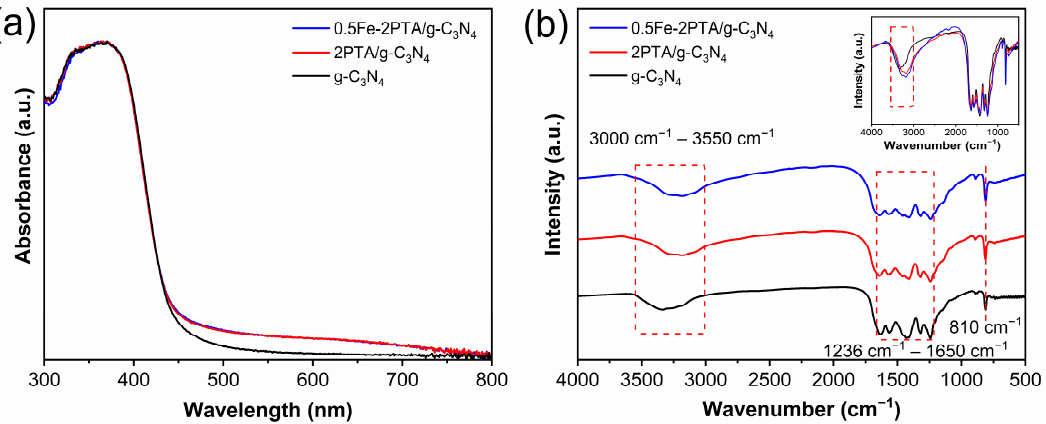
Figure 2. ( a ) UV–Vis diffuse reflection spectra and ( b ) FT-IR patterns of g-C 3 N 4 , 2PTA/g-C 3 N 4 and 0.5Fe-2PTA/g-C 3 N 4 (inset shows comparison of three FT-IR curves). To investigate the interface interactions between PTA and g-C 3 N 4 in PTA/g-C 3 N 4 , Fourier-transform infrared (FTIR, Bruker, Karlsruhe, Germany) spectra of the samples were analyzed, as shown in Figures 2b and S3. As shown in Figure S3a, PTA shows the carboxylic O-H and C=O stretching peaks at 3400 and 1610 cm − 1 , C-H stretching peaks at 3098, 2965 and 2915 cm − 1 , thiophene ring vibration peaks at 1533, 1437 and 1356 cm − 1 and the C-S stretching vibration peak of the thiophene ring at 902 cm − 1 [41–44]. It is worth noting that PTA presents a substantial absorption peak at 788 cm − 1 , corresponding to C β -H out-of-plane vibration, indicating that the α - α coupling is the dominant form of C-C bonding for the as-prepared PTA and there is almost no α - β coupling form [45]. As illus- trated in Figure 2b, g-C 3 N 4 shows a broad peak at around 3000–3550 cm − 1 , originating from the terminal -NH 2 . The peak at around 810 cm − 1 is assigned to the hepazine ring bending vibration, and the set of peaks from 1236 cm − 1 to 1650 cm − 1 is ascribed to the C-N hetero- cycle stretching vibration [46,47]. By comparison, in xPTA/g-C 3 N 4 (Figures 2b and S3), the -NH 2 absorption peak moves to a lower direction, indicating the interaction between the -COOH of PTA and the -NH 2 of g-C 3 N 4 . Compared with 2PTA/g-C 3 N 4 , 0.5Fe-2PTA/g-C 3 N 4